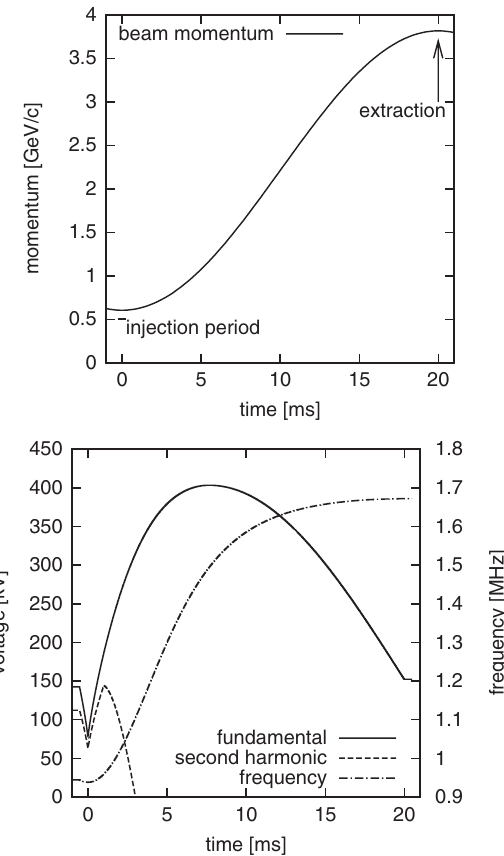
FIG. 9. (upper) Beam momentum in the accelerating cycle. (lower) Accelerating voltage program with 80% second har- monic and frequency program. t ¼ 0 corresponds to B beam is injected from 117 turns before B B min